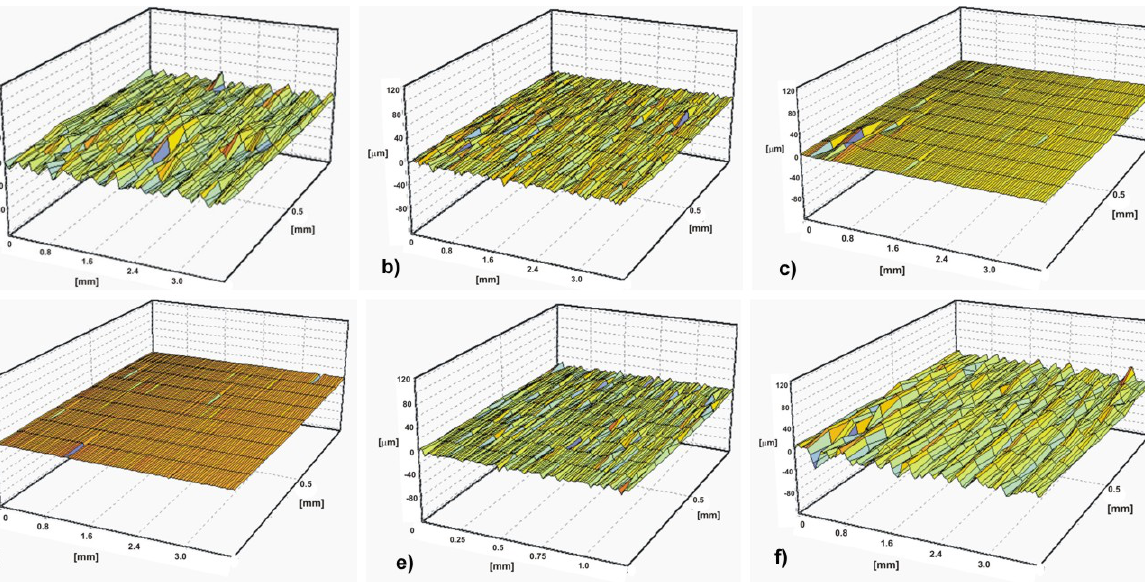
Figure 49. Surface roughness as a result of different cleaning techniques: a) glass beads;